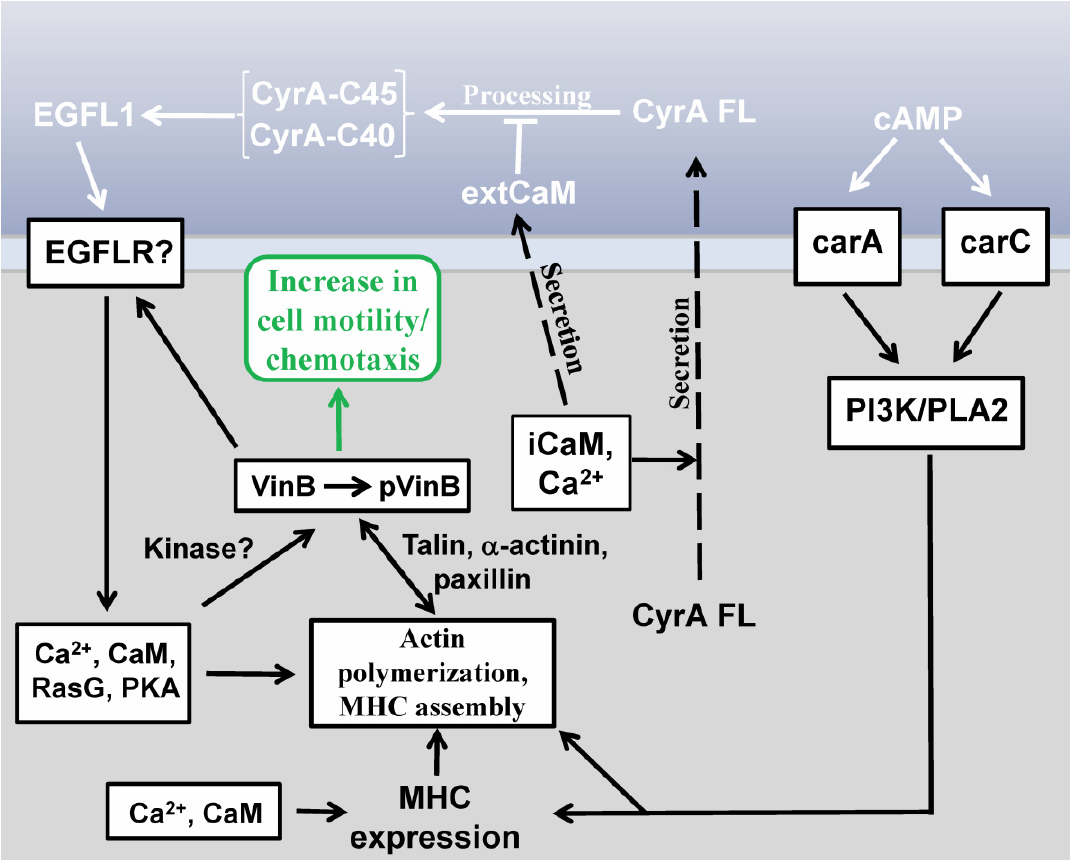
Figure 2. The primary signal transduction events mediating the increase in cell motility and chemotaxis induced by EGFL1. Secretion of full-length CyrA (CyrA FL) is Ca 2+ and calmodulin (CaM) dependent. Extracellularly CyrA FL becomes part of the extracellular matrix where it is processed releasing two smaller EGFL repeat-containing C-terminal fragments of ~45 kDa (CyrA-C45) and ~40 kDa (CyrA-C40). This proteolytic cleavage is inhibited by extracellular CaM (extCaM). At least one EGFL repeat ( i.e. , EGFL1) within the 45kDa and 40kDa CyrA fragments binds to an unidentified receptor to activate intracellular signaling events which will ultimately increase both random cell motility and chemotaxis (rounded box). As detailed in the main text, these signaling events involve kinase signaling (e.g., PKA), Ca 2+ , CaM, and Ras G which oversee actin polymerization and myosin heavy chain (MHC) assembly. For cells responding chemotactically to cAMP via carA or carC, stimulation of the PI3K/PLA2 signaling pathways increases MHC expression, MHC assembly and actin polymerization. MHC expression is also regulated by Ca 2+ and intracellular CaM (iCaM). Ca 2+ , iCaM, Ras G plus an unidentified kinase also are involved in the sustained phosphorylation of vinculin B-related (VinB) induced by EGFL1. Phosphorylated VinB (pVinB) working in conjunction with binding proteins talin, (cid:68) -actinin and paxillin along with the actin cytoskeleton, leads to increased cell motility and chemotaxis. The details of each step in the figure are covered in the main text of this